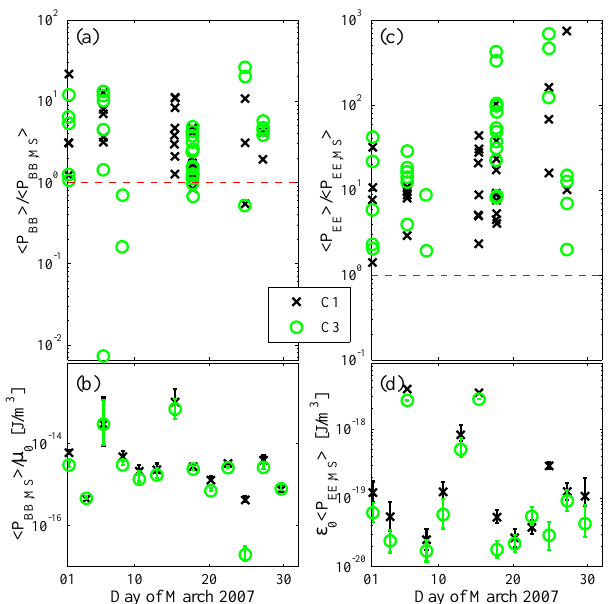
Figure 10. Magnetic and electric energy of waves measured by STAFF. (a) Magnetic energy density for each plasmoid measured by Cluster 1 and 3 normalised to the magnetosheath value of the same date; (b) magnetic energy density in the magnetosheath; (c) electric energy density for each plasmoid normalised to the magnetosheath value of the same date; and (d) electric energy density in the magnetosheath. The magnetosheath values in panels (b) and (d) are shown for all outbound orbits, also those when no plasmoids were observed. The error bars indicate the values corresponding to one standard deviation upward and downward of the logarithm of the energy density computed in 30 s intervals. In all panels, observations made by Cluster 1 are marked “ × ” and observations made by Cluster 3 are marked “ ◦ ”, the former black and the latter green.